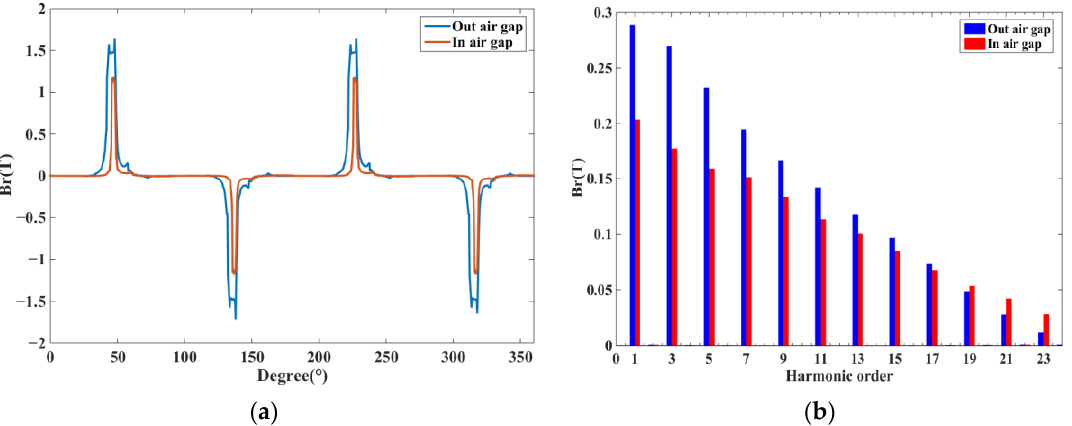
Figure 9. Radial magnetic density of the air-gap space inside the outer air gap of DDSRG. ( a ) Magnetic density waveform diagram. ( b ) Harmonic decomposition.